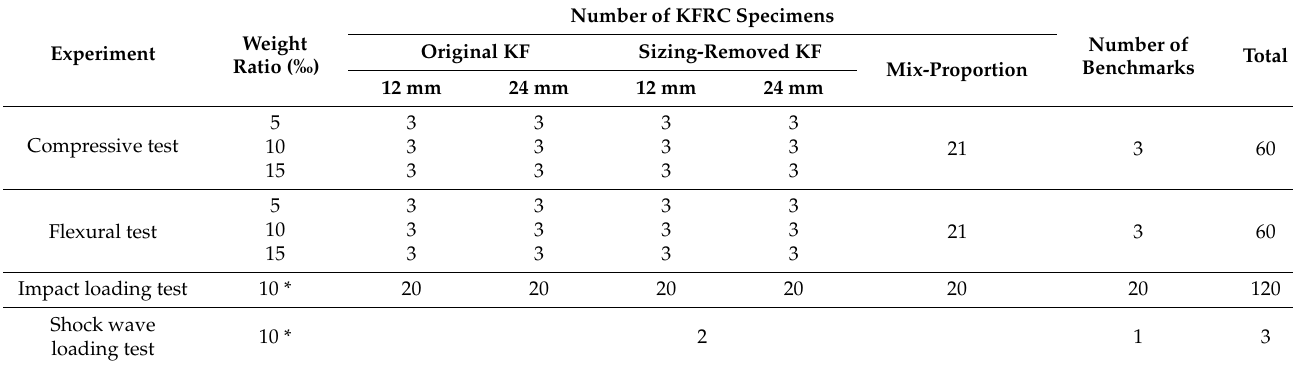
Table 4. The initial plan for KFRC